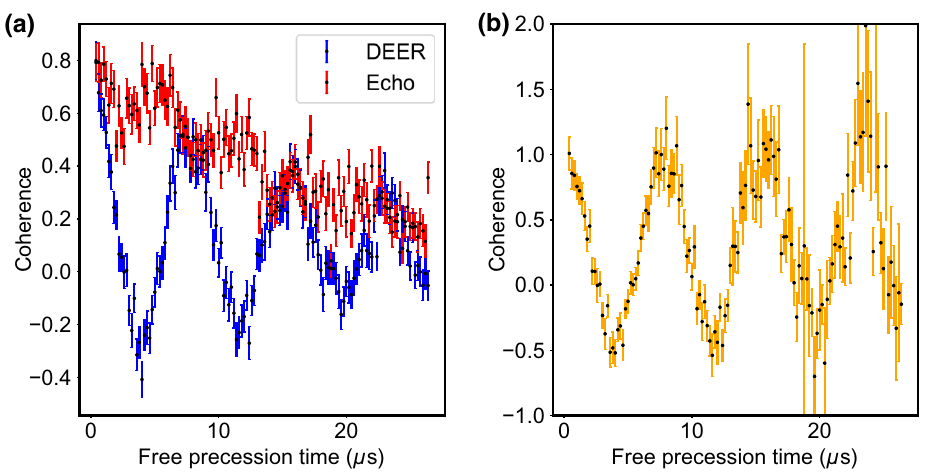
FIG. 9. Coherently coupled surface spin. (a) Raw DEER (blue) and echo (red) data from a NV center that is coherently coupled to a surface spin. (b) The raw DEER signal divided by the echo signal.